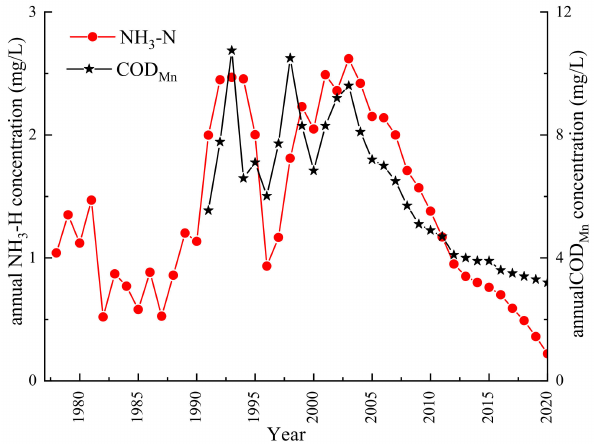
Figure 3. The annual concentration of NH 3 -N and COD Mn during